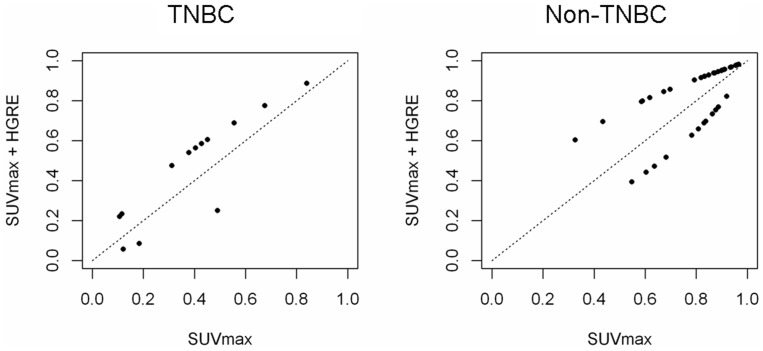
Plots of the patients with TNBC (left) and non-TNBC (right) illustrating the effect of including a texture parameter (HGRE) in addition to SUVmax for classification of breast cancer.In both tumor groups (TNBC and non-TNBC), adding HGRE to SUVmax improves the classification of the tumor if the patient is located above the diagonal. The probability of correct classification increased in 77% of TNBC (10/13) and in 71% (29/41) of non-TNBC (NRI = 0.95, p = 0.003). A perfect combination of indices would reclassify 100% of patients above the diagonal (NRI equal to 2).